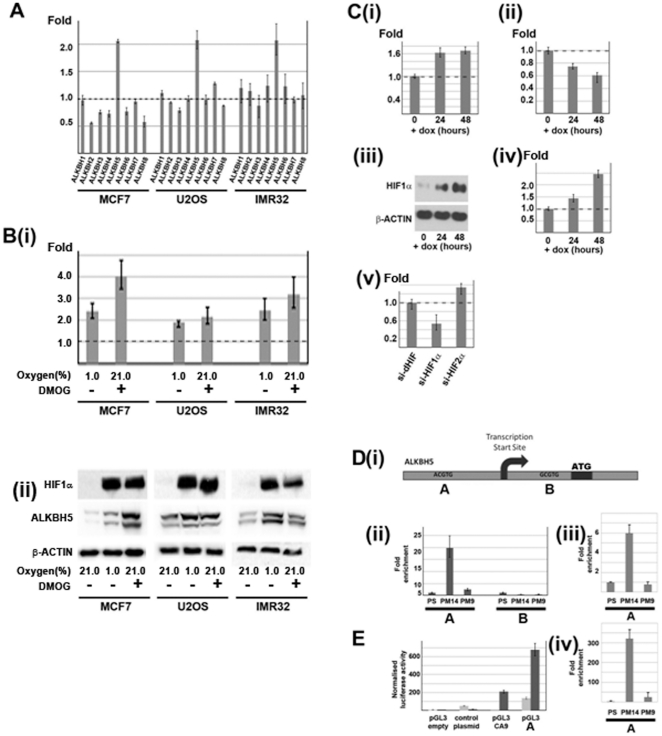
Hypoxia upregulates ALKBH5 via HIF-1α.(A) Hypoxic induction of ALKBH1-8 in MCF7, U2OS and IMR32 cells. Values are the fold increase in mRNA in cells cultured for 16 hours in hypoxia (1.0% oxygen) relative to parallel cultures in normoxia (21% oxygen). Only ALKBH5 is significantly upregulated (p<0.01) in each cell type. (B)(i) ALKBH5 mRNA was significantly induced in MCF7, U2OS and IMR32 cells by hypoxia (1.0% oxygen for 16 hours) and DMOG (1 mM for 16 hours). (ii) Immunoblot demonstrating increased protein levels of HIF-1α (top panel) and ALKBH5 (middle panel) under hypoxia and DMOG treatment. Protein loading is indicated by β-actin signal (bottom panel). (C) Genetic manipulation of the HIF/VHL system in normoxia modulates ALKBH5 expression. Inducible HIF-1α overexpression in U2OS cells and subsequent RT-Q-PCR analysis (i) shows a significant increase in ALKBH5 mRNA after doxycycline administration. Expression of VHL in RCC4 cells and subsequent RT-Q-PCR analysis (ii) shows significant decrease in ALKBH5 mRNA by 48 hours after doxycycline administration. Inducible peptide blockade of HIF-1α degradation demonstrating increased expression of HIF-1α protein (iii) at 24 hours (lane 2) and 48 hours (lane 3). RT-Q-PCR analysis (iv) shows a significant (p<0.01) increase in ALKBH5 mRNA after doxycycline administration. RT-Q-PCR analysis (v) demonstrates significant reduction in hypoxic induction of ALKBH5 mRNA by HIF-1α directed siRNA. These changes were not observed in siRNA directed against Drosophila HIFα or human HIF-2α. Knockdown for each HIFα subunit was greater than 90% as confirmed by both RT-Q-PCR and immunoblotting (data not shown). (D) HIF-1α binds the −482 to −486 promoter region of the ALKBH5 gene and mediates hypoxic induction of a luciferase reporter in MCF7 cells. (i) Figure indicating 2 putative HREs (A,B) and their relative positions to the transcriptional and translational start sites. (ii) DNA encompassing HRE A was significantly enriched in chromatin precipitated with PM14 (anti-HIF-1α) but not with pre-immune sera (PS) or PM9 (anti-HIF-2α) in both (iii) CAKI-1 and (iv) RCC4 renal cancer cells. No enrichment was observed in DNA encompassing HRE B. (E) MCF7 cells were transfected with pGL3promoter vectors expressing the putative ALKBH5 HRE A sequence. pGL3promoter vectors that were either “empty” or contained the CA9 HRE served as controls as did an “irrelevant” vector. Luciferase activities were normalized to those of β-galactosidase in each sample. Luciferase activity was significantly increased after 16 hours of DMOG (1 mM) treatment in cells expressing pGL3-CA9 and pGL3-ALKBH5[HRE A] but not in the control plasmid or “empty vector.